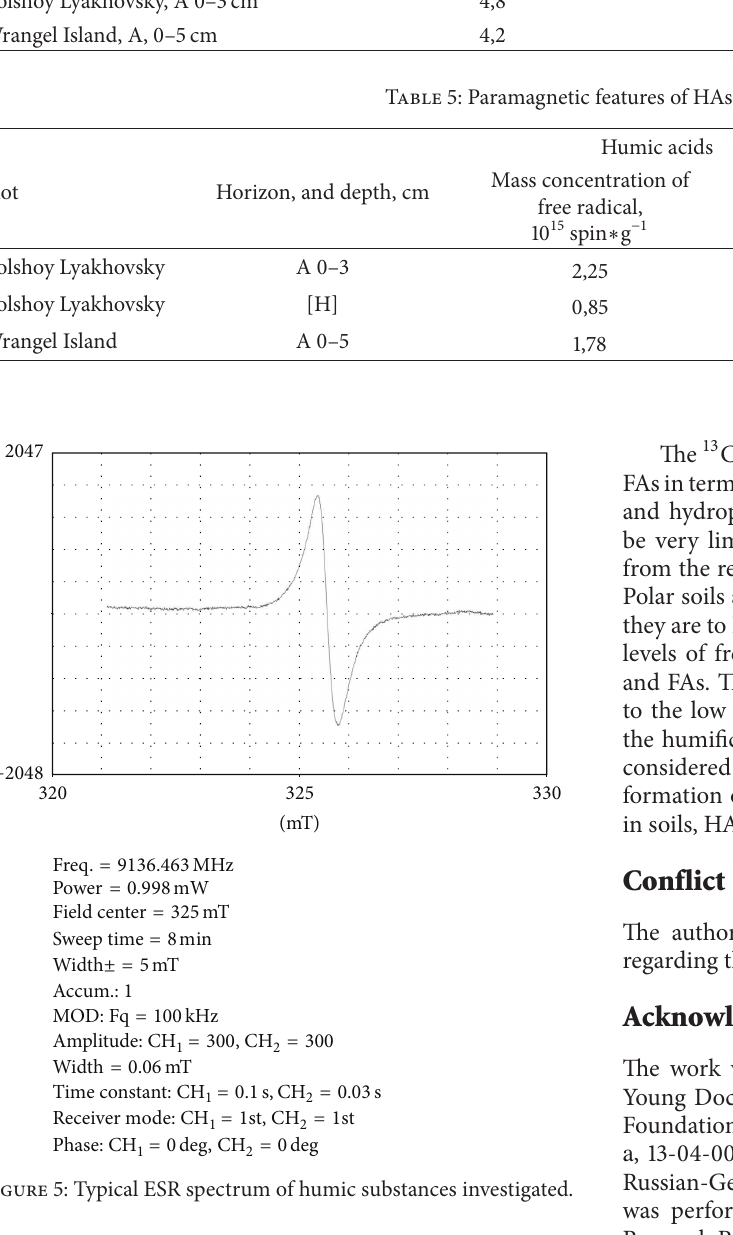
lower content of oxygen-containing groups in comparison with FAs, while the degree of aromaticity is two or three times higher than in FAs. The degree of aromaticity of buried organic material from Bolshoi Lyakhovsky Island is greater than that in the humus horizon of the modern